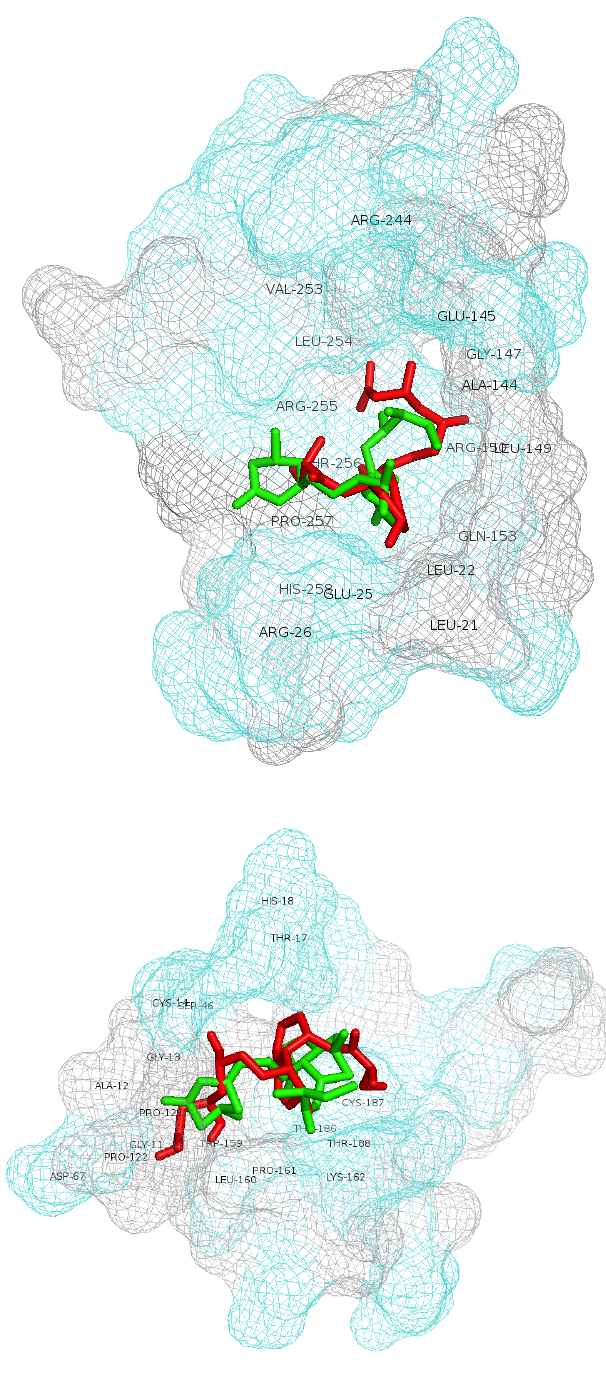
Figure 2. Best scoring lovastatin-lactone and -hydroxyacid poses in A5UMI1 3IQZB_SiteSeeker2 (top) and Q02394 4JJF_SiteSeeker (bottom). Lovastatin-lactone form is shown with green sticks and hydroxyacid form with red sticks. Residues within 5 angstroms of ligands are labeled. Hydrophilic site residues are shown in cyan and hydrophobic residues in